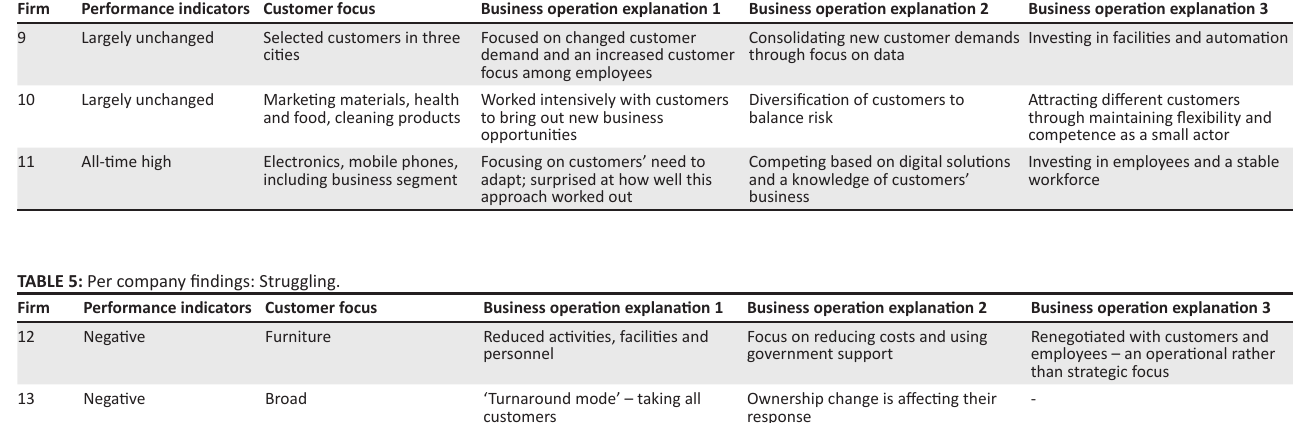
TABLE 4: Per company findings: Customer-oriented. Firm Performance indicators Customer focus